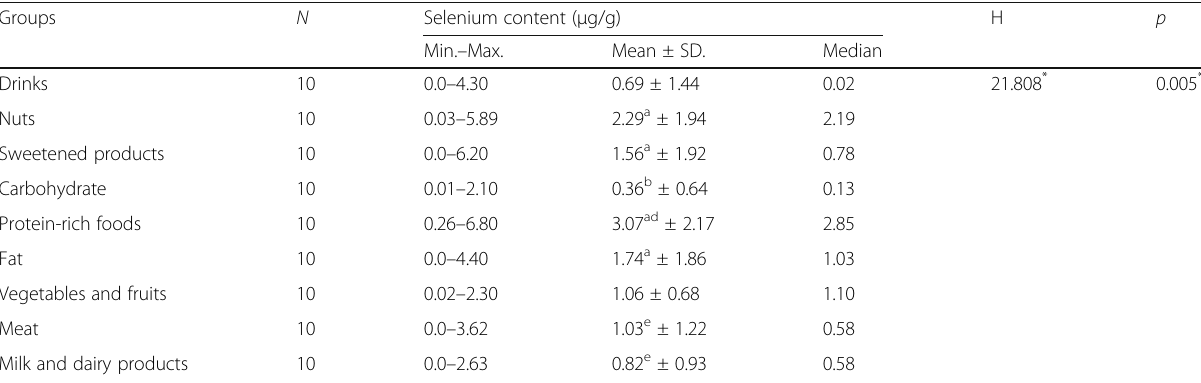
Table 2 Comparison between the nine studied groups according to selenium content ( μ g/g) Groups N